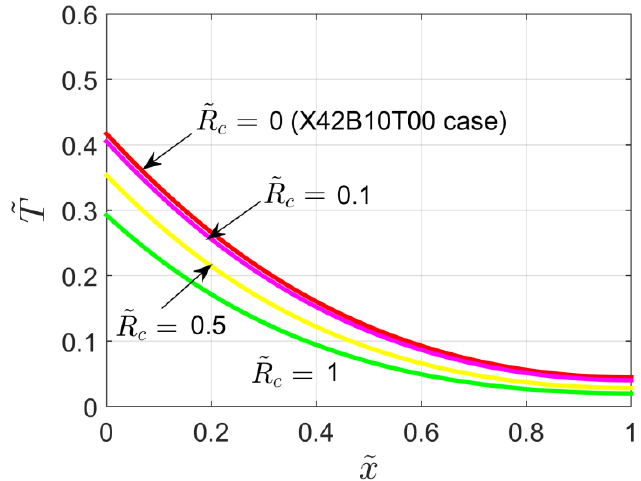
Figure 12. Dimensionless temperature distribution for the X62B10T00 problem for different values of the dimensionless contact resistance and P = 0.1.